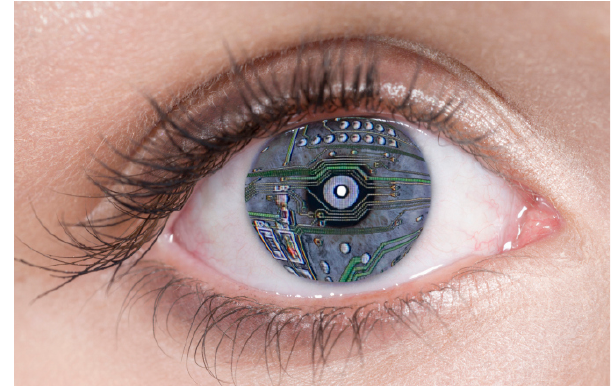
Figure 1. Blue eye with PC circuit board